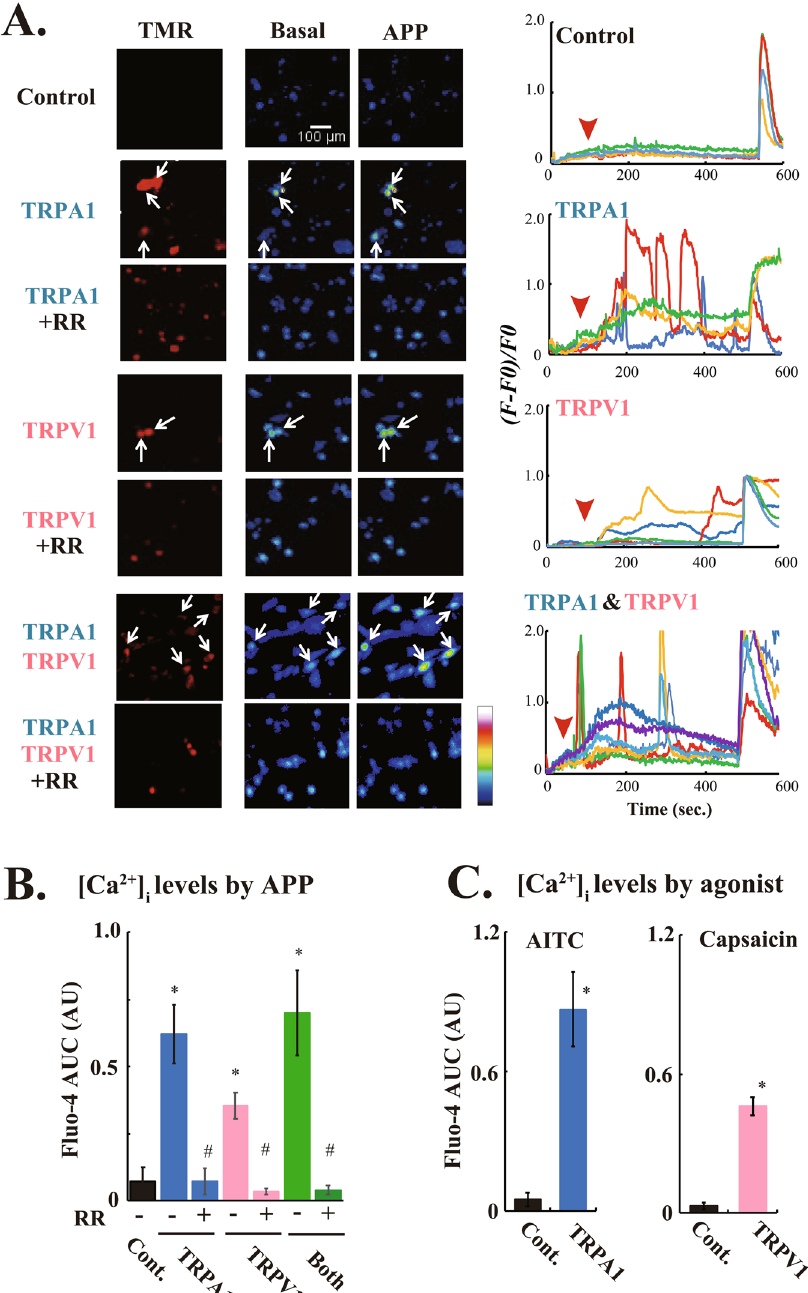
Figure 3. Exogeneous expression of either TRPA1 or TRPV1 generates APP-responsiveness in C2C12 cells. ( A ) Pseudo-color images showing [Ca 2 + ] i elevation in C2C12 cells exogenously expressing either Halo-TRPA1 or TRPV1-Halo, alone or in combination (red cells in the left panels) stimulated with APP-HBS in the absence or presence of 100 μ M ruthenium red (RR). The graphs on the right are representative single-cell traces of Fluo-4 fluorescence from the experiments shown on the left (-RR only), expressed as (F − F0 )/ F0 . APP-HBS was applied at approximately 50~100 sec. ( red arrowheads ), and then ionomycin was added. ( B ) Quantification of the indirect APP-responsive [Ca 2 + ] i transients in C2C12 myoblasts expressing either TRPA1 (blue bar) or TRPV1 (pink bar), alone or in combination (green bar), with or without 100 μ M RR from 3 independent experiments. AUC were evaluated for 300 sec. in total after APP-HBS administration. For each experiment, more than 10 transfected cells (TMR-positive cells) from each glass-bottom dish were measured. Statistical significance was determined by applying the Dunnett’s multiple comparison versus the control (parental C2C12 cells). The effects of exogenous expression of TRPA1 and TRPV1, alone or in combination, are indicated by * ( P < 0.05), and the effects of RR are indicated by # ( P < 0.05). ( C ) Quantification of agonist-dependent [Ca 2 + ] i transients in C2C12 myoblasts exogenously expressing either TRPA1 (blue bar) or TRPV1 (pink bar) channels from 3 independent experiments. AUC was evaluated from 100–500 sec., and results are expressed as the fold increase versus the AUC obtained from the parental C2C12 cells. For each experiment, more